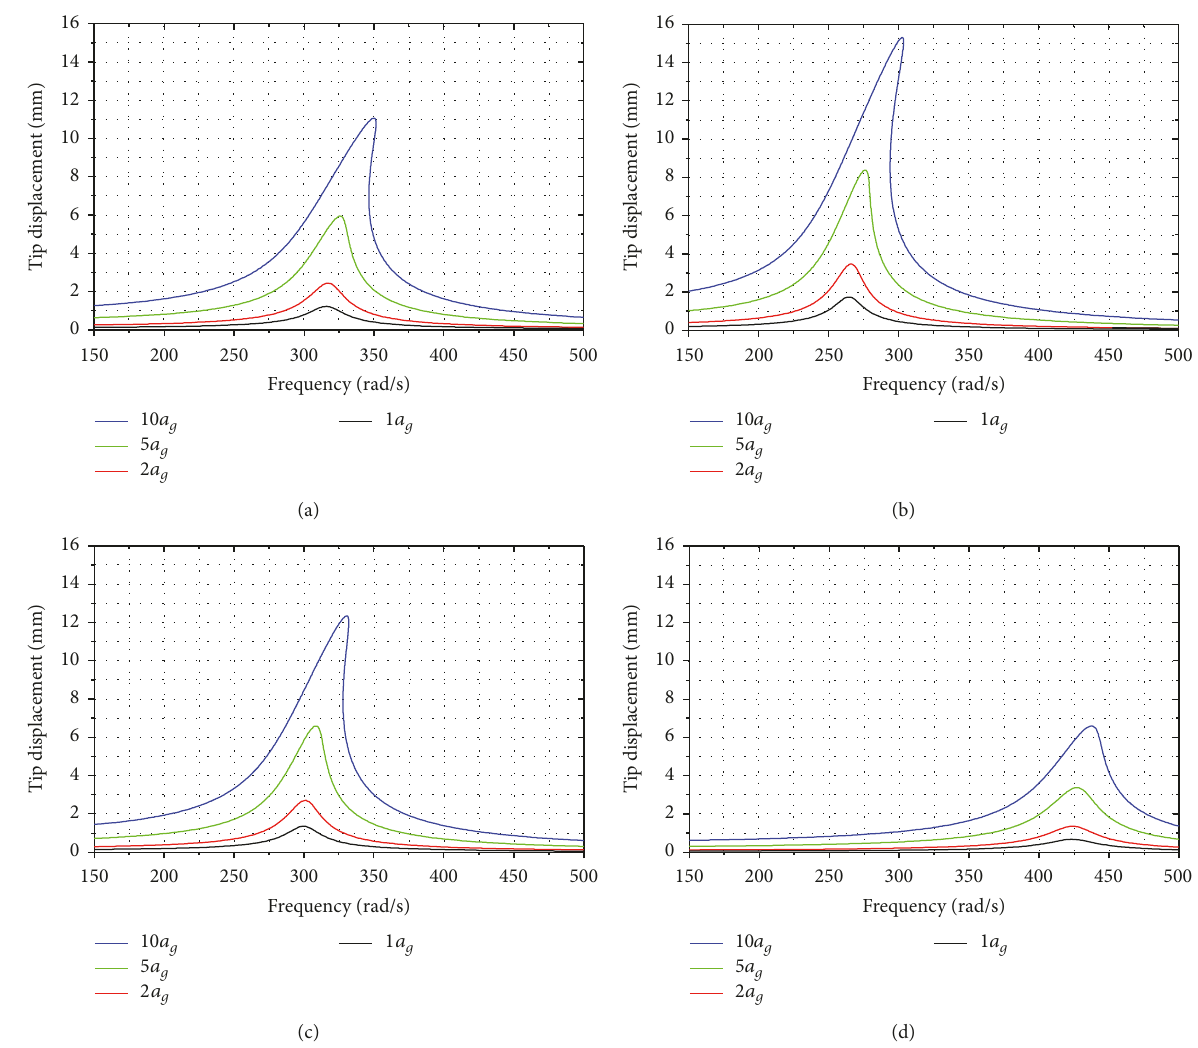
Figure 15: FRFs of the maximum tip displacement for base acceleration amplitudes ranging from 1 𝑎 𝑔 to 10 𝑎 𝑔 , where (a) 𝑇 mylar = 𝑇 0 mylar , (b) 𝑇 = 0.8𝑇 0 𝑇 = 0.9𝑇 0 𝑇 = 1.2𝑇 0 mylar mylar mylar mylar , (c) mylar , and (d) mylar